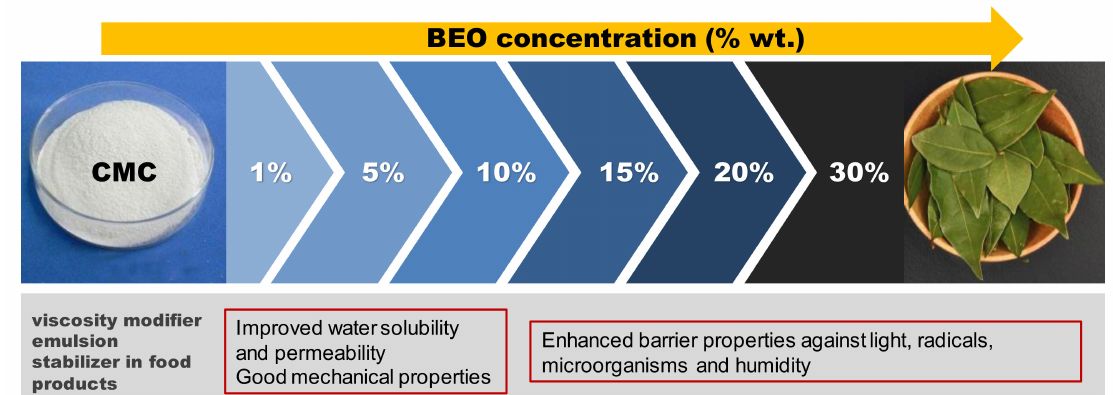
Figure 8. Potential applications of formulated BEO-CMC films.